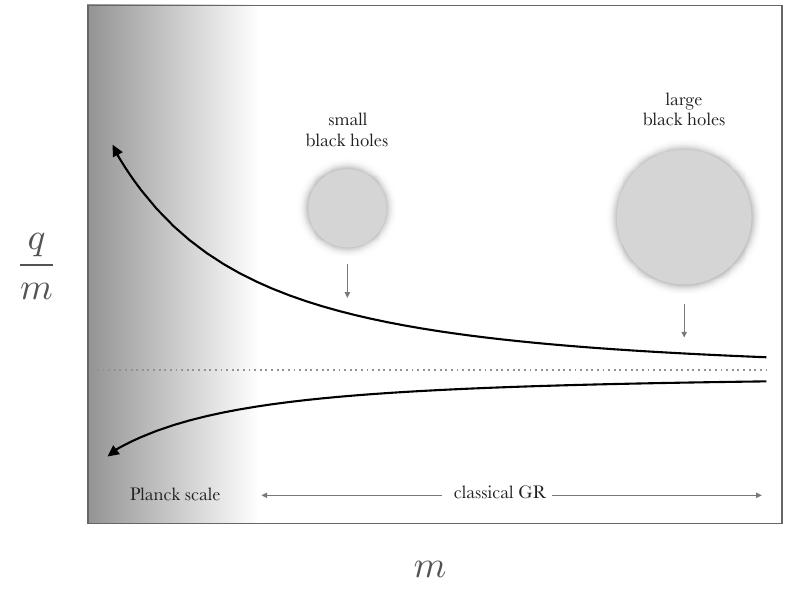
Figure 1 . Black holes of maximal charge shown as a function of mass m and charge-to-mass ratio q=m . Higher-dimension operators induce corrections to the extremality condition. If these corrections are positive, then the WGC is automatically satis(cid:12)ed (upper solid curve) since large black holes are unstable to decay to smaller ones. If these corrections are negative (lower solid curve), then the WGC mandates additional light, superextremal particles to avoid an in(cid:12)nite number of stable extremal black hole